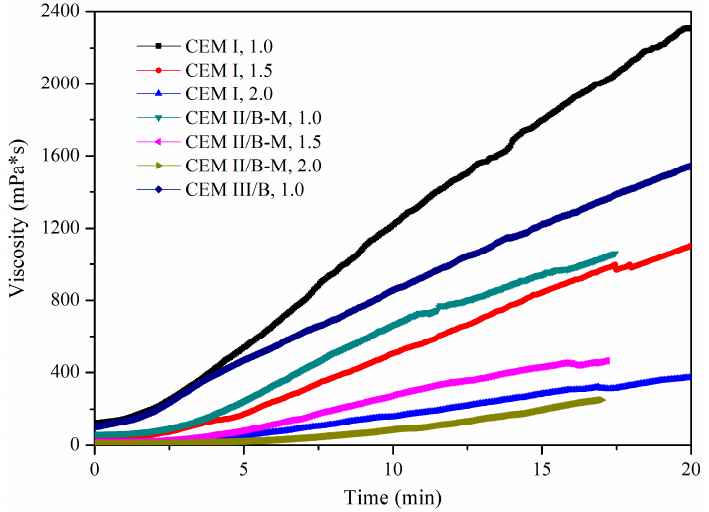
Figure 5. Effect of cement type and W/S on viscosity variation of fresh SMCG (0% SP) within initial 20 min.